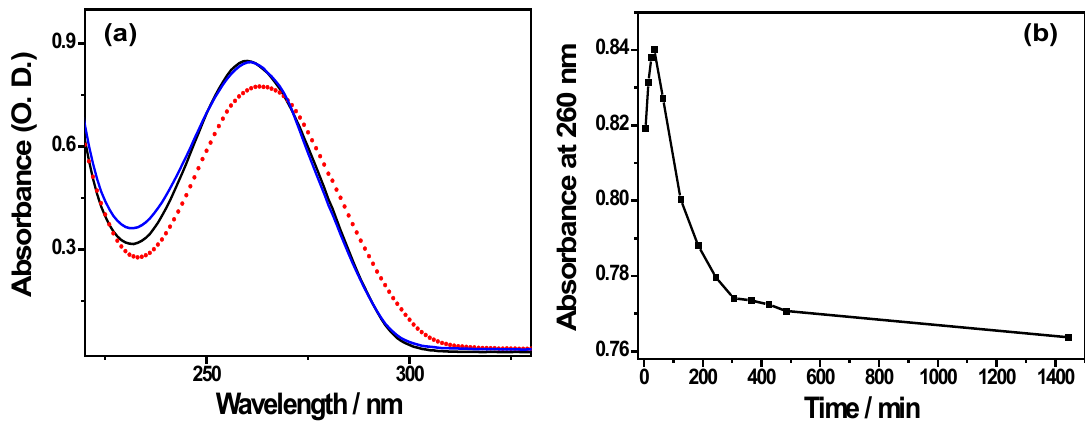
Figure 1. ( a ) UV spectra of Li28 at pH = 7.5 (black line), after 24 h at pH = 2.5 (red points) and 2 h after addition of NaOH for adjustment at pH = 7.5 (blue line); ( b ) Evolution of the Li28 absorbance at pH = 2.5 with time. [Li28] = 3